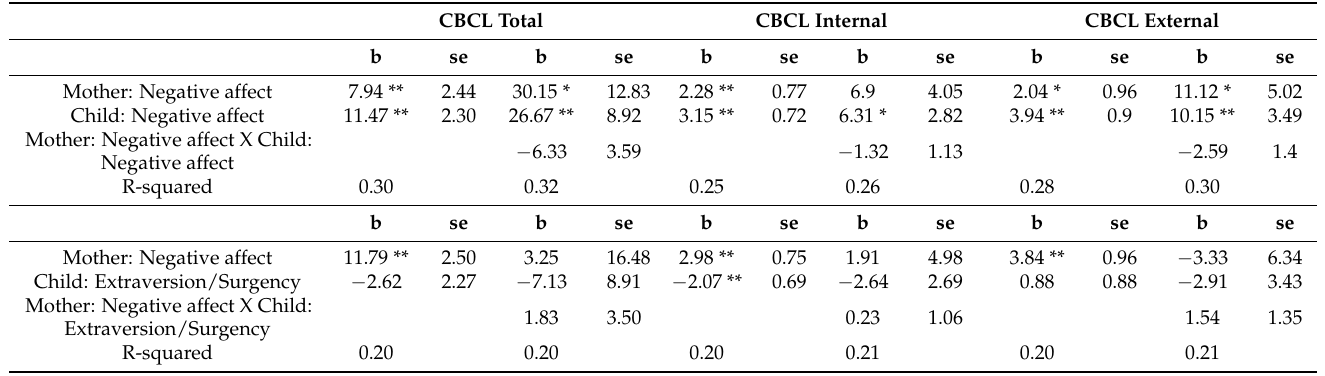
Table 4. The associations between maternal and child negative affect and child problem behavior.